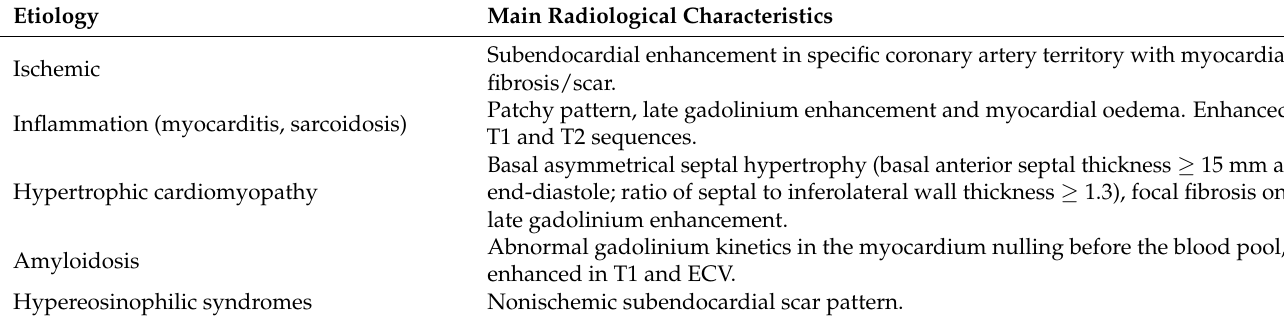
Table 3. Cardiac resonance magnetic imaging findings in different HFpEF etiologies.